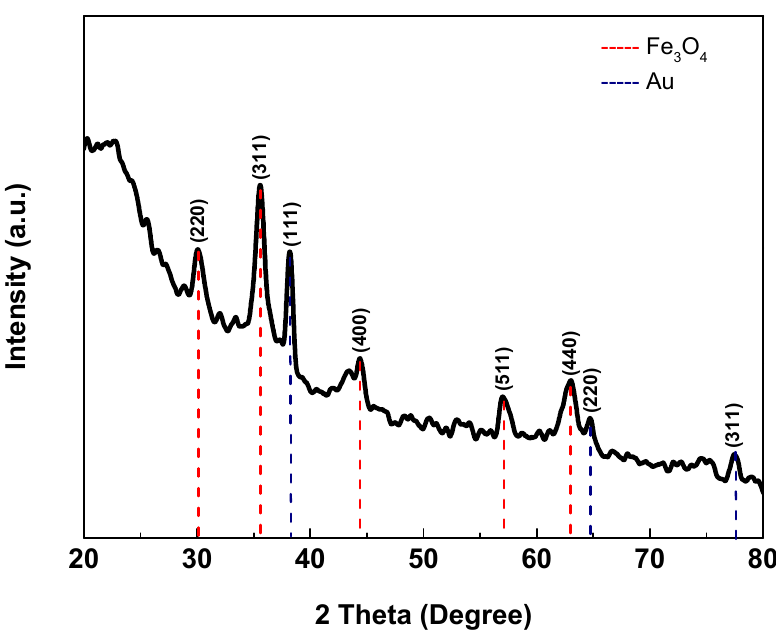
Figure 1. XRD patterns of Au-SiO 2 @Fe 3 O 4 -RGO. Typical peaks of Au are marked with red dotted line, and typical peaks of Fe 3 O 4 are marked with blue dotted line.